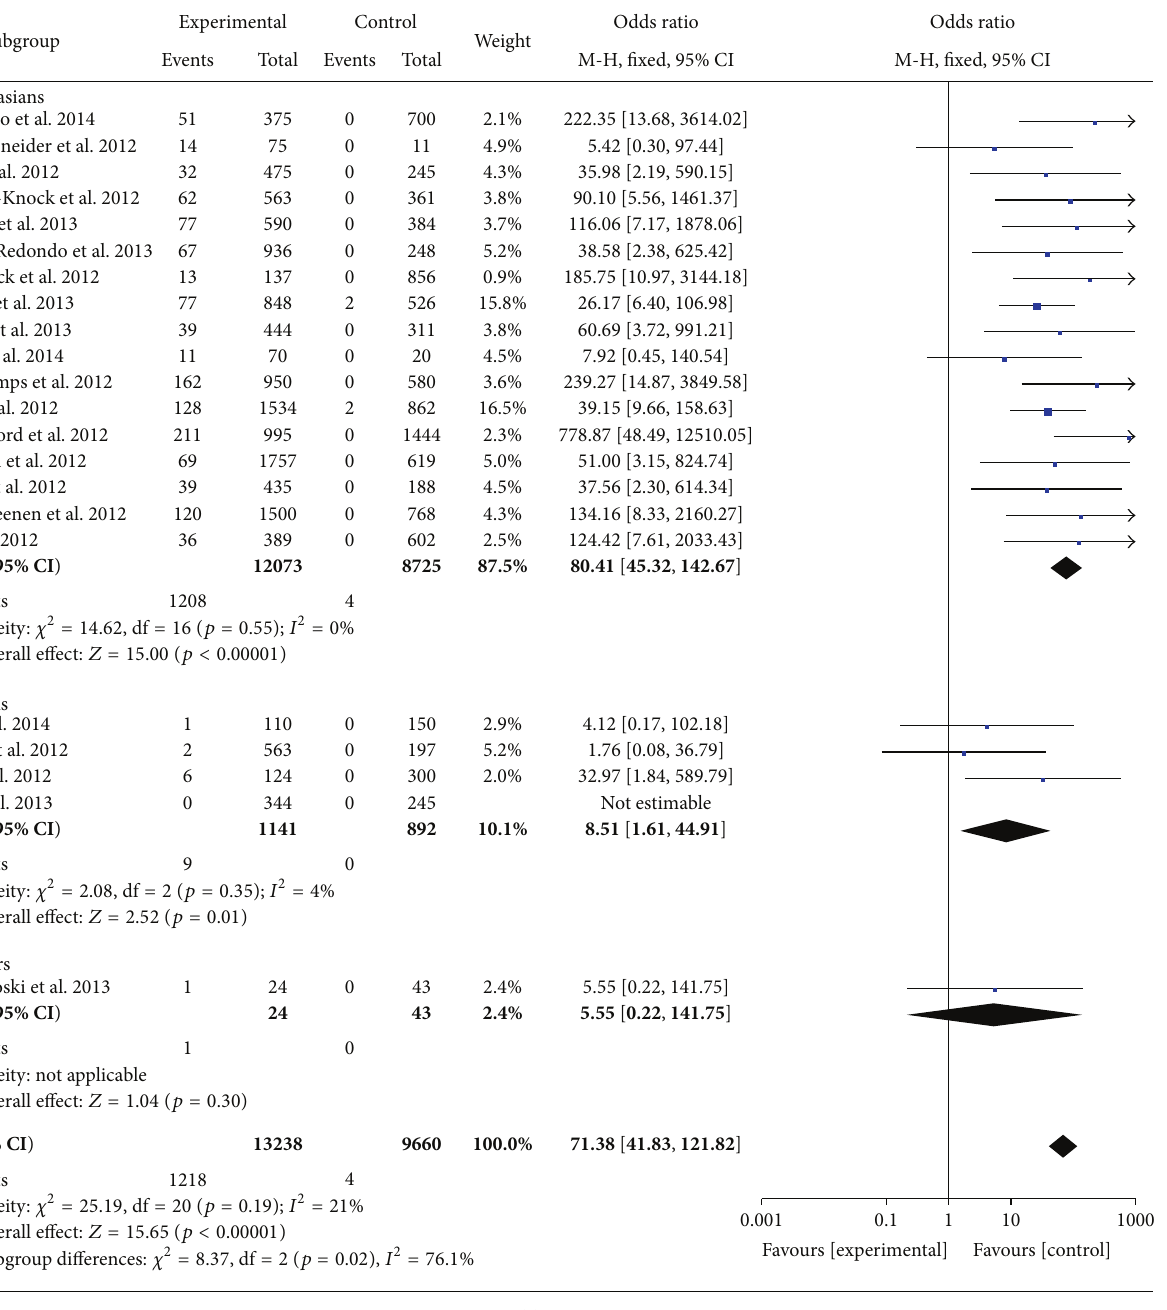
Figure 2: (a) Forest plot of the association between C9orf72 repeat expansions and familial ALS. (b) Forest plot of the association between C9orf72 repeat expansions and sporadic ALS. (c) Forest plot of the association between C9orf72 repeat expansions and ALS (subgroup